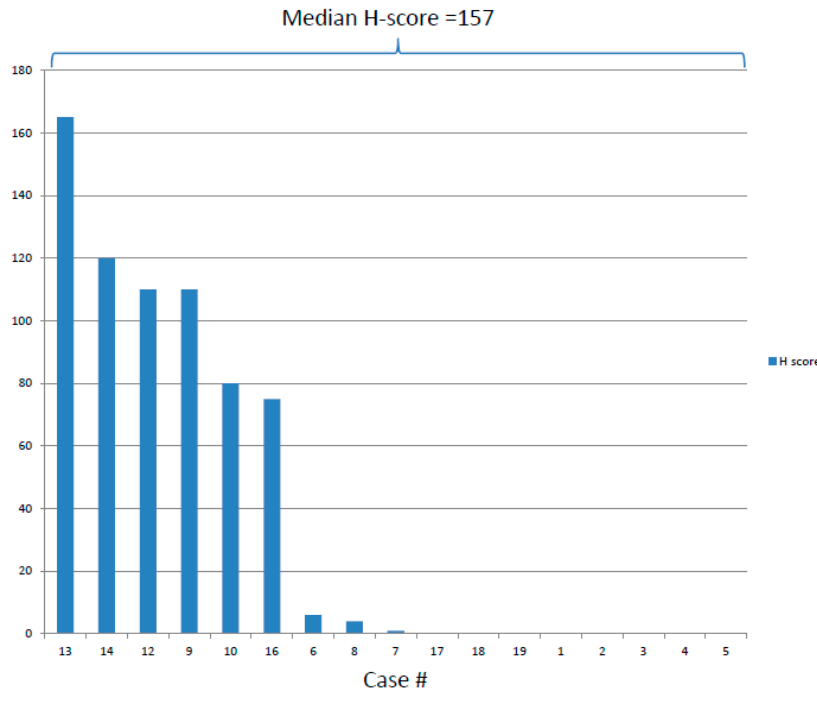
Figure 2. PD-L1 expression H-scores based on tumor cell staining by immunohistochemistry using the 22C3 antibody clone.